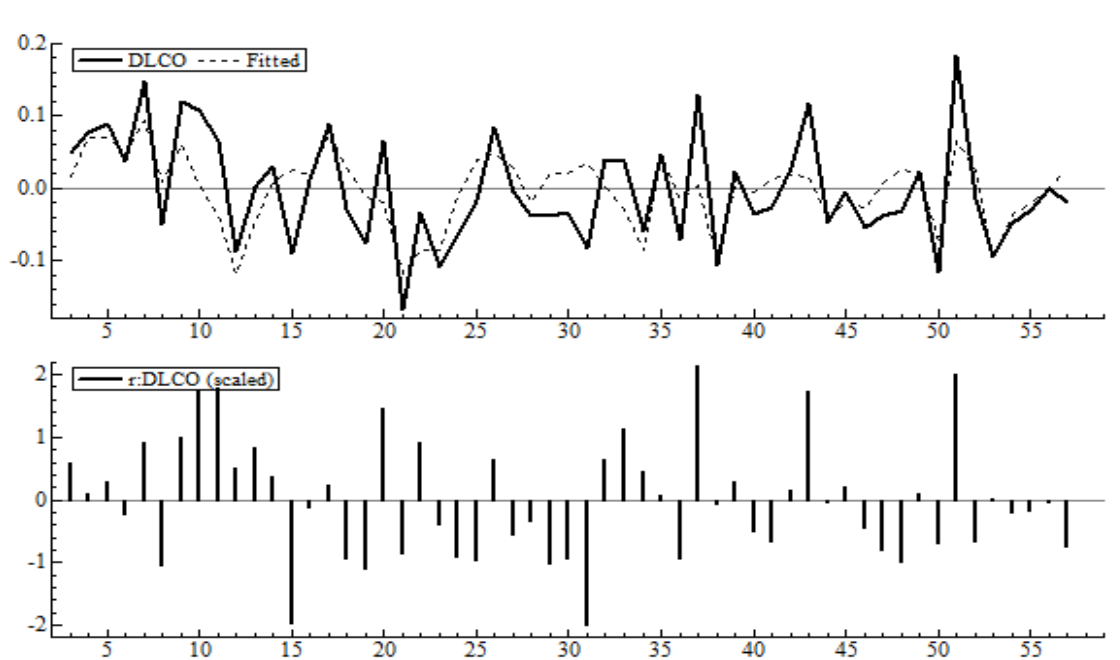
Figure 3. Results for the Sweden long-term model: 1. See Equation (1). Fitted model top graph, residuals bottom graph.